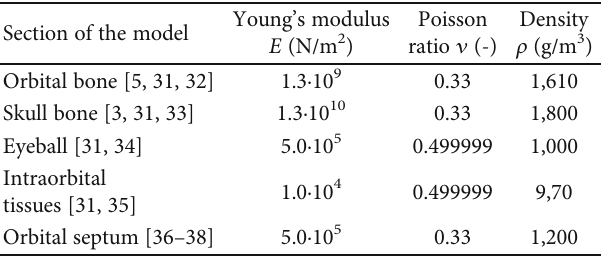
Table 1: Material properties applied to the FEM models of the human orbit ’ s